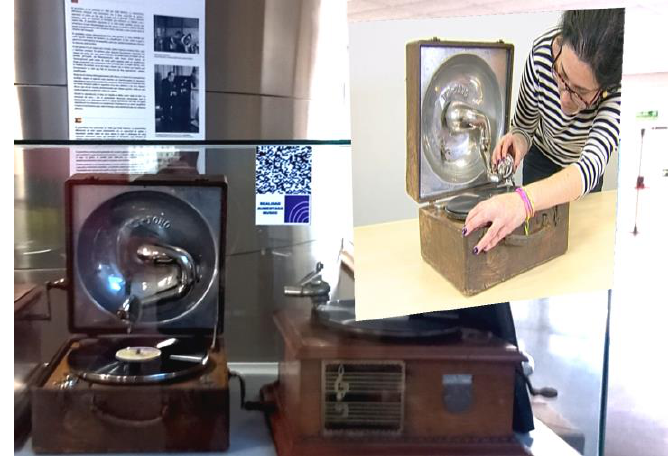
Figure 4. AR video content of the 1920 Ica-Fono gramophone.